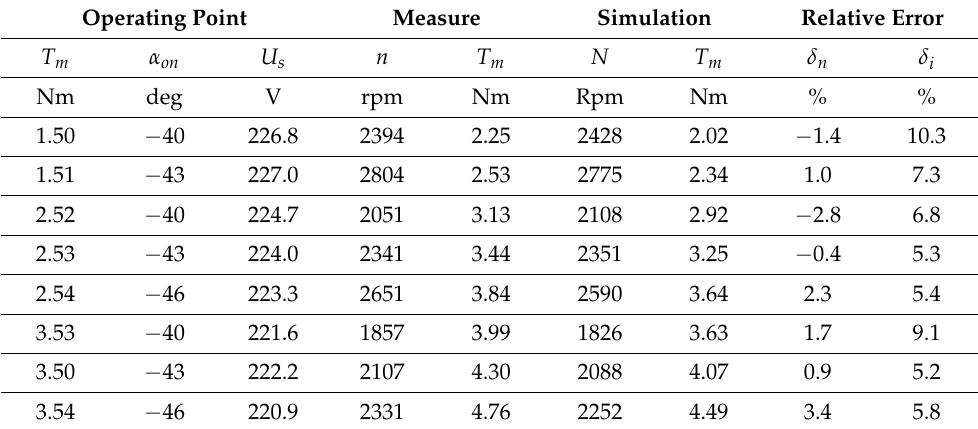
Table 4. Measurement verifications of calculation results for various values of